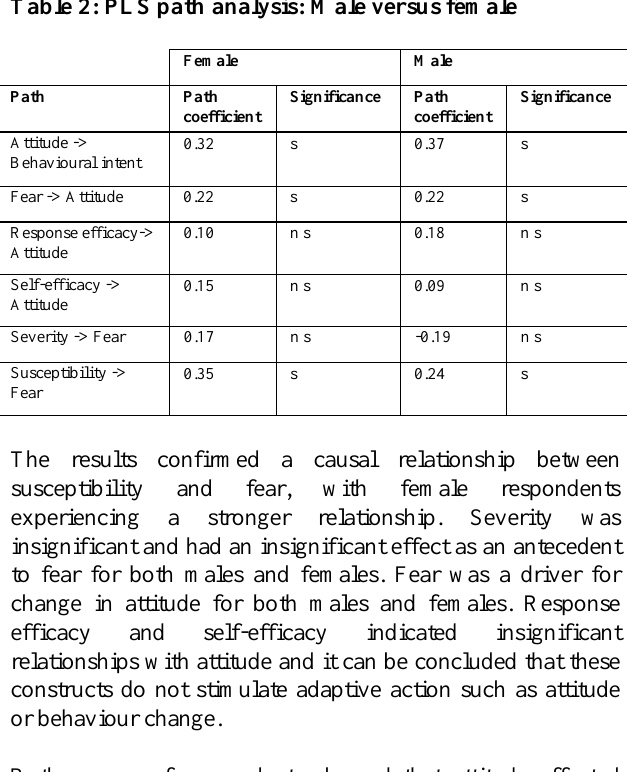
Table 2: PLS path analysis: Male versus female